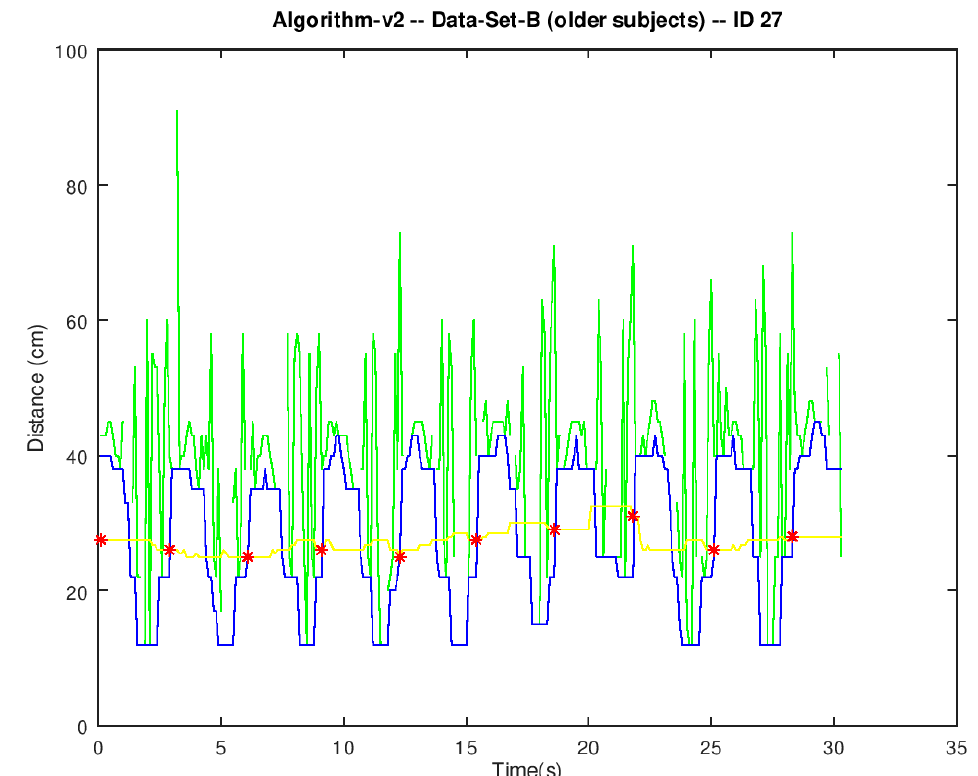
Figure 6. Graphical representation of a signal from dataset B (older subjects) and the outcomes resulting from processing it with Algorithm-v2. The green line represents the pre-processed signal after removing all the outliers over a given threshold. The blue line represents the output of applying a moving minimum filter to the green signal. The filter completely cancels the e ff ect of the spurious spikes in the green signal. The red dots represent the sit-to-stand transitions identified and reported by the